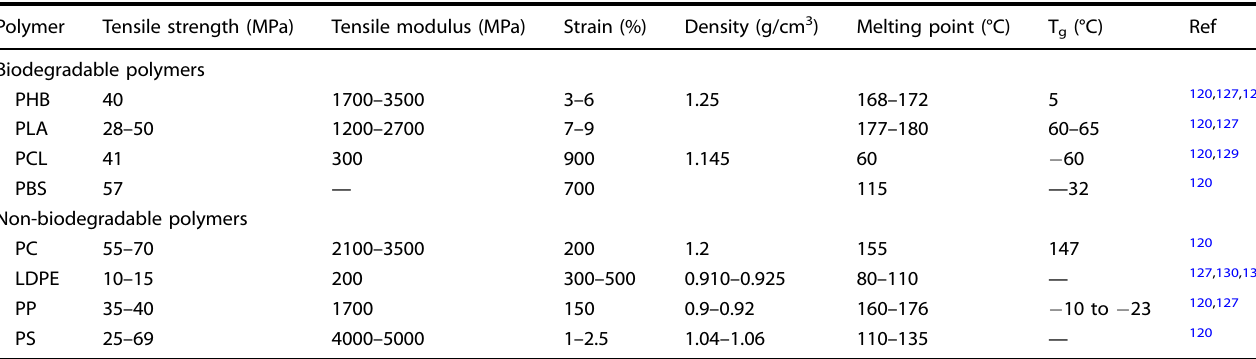
Table 4. Physical and mechanical properties of some biodegradable polymers and non-biodegradable polymers. Polymer Tensile strength (MPa)